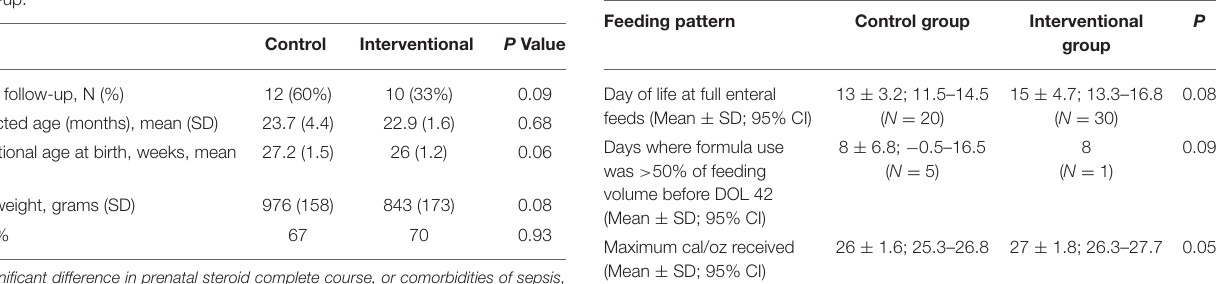
TABLE 5 | Feeding